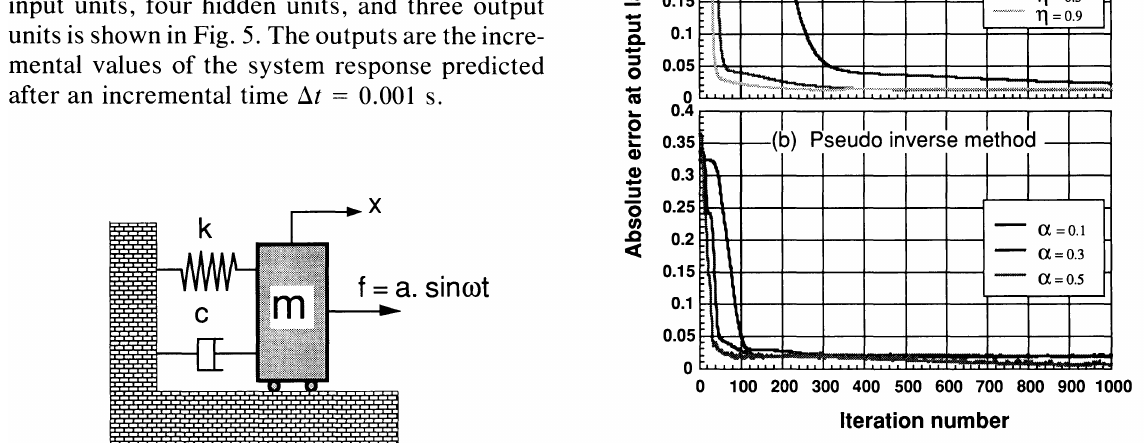
FIGURE 6 History of absolute error for dynamic sys tem identification oflinear single degree freedom mass spring